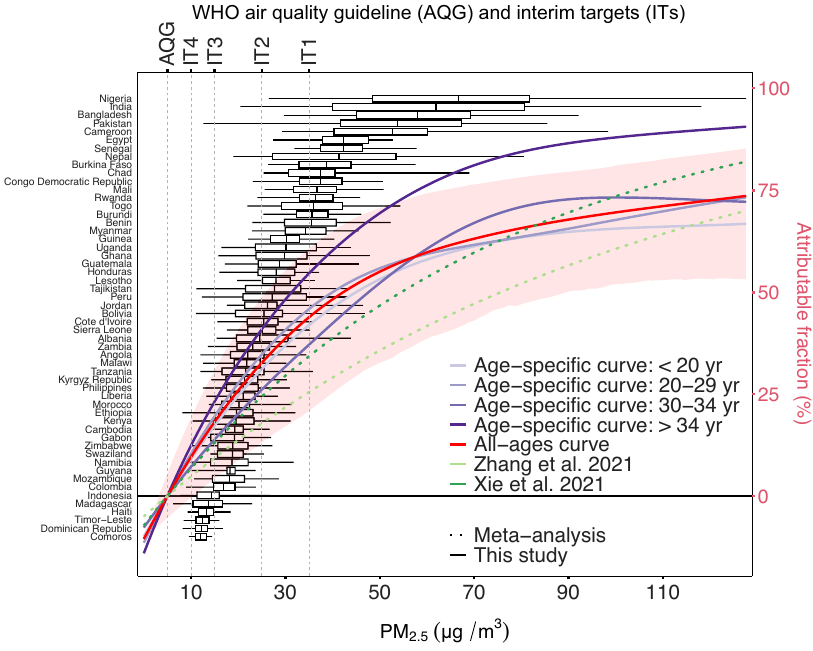
barsaremedians;theboxboundsandwhiskersindicateforrangesfrom25 th to75 th and from 2.5 th to 97.5 th percentile, respectively.). The red ribbon is the pointwise 95% con fi dence interval for the all-ages curve.